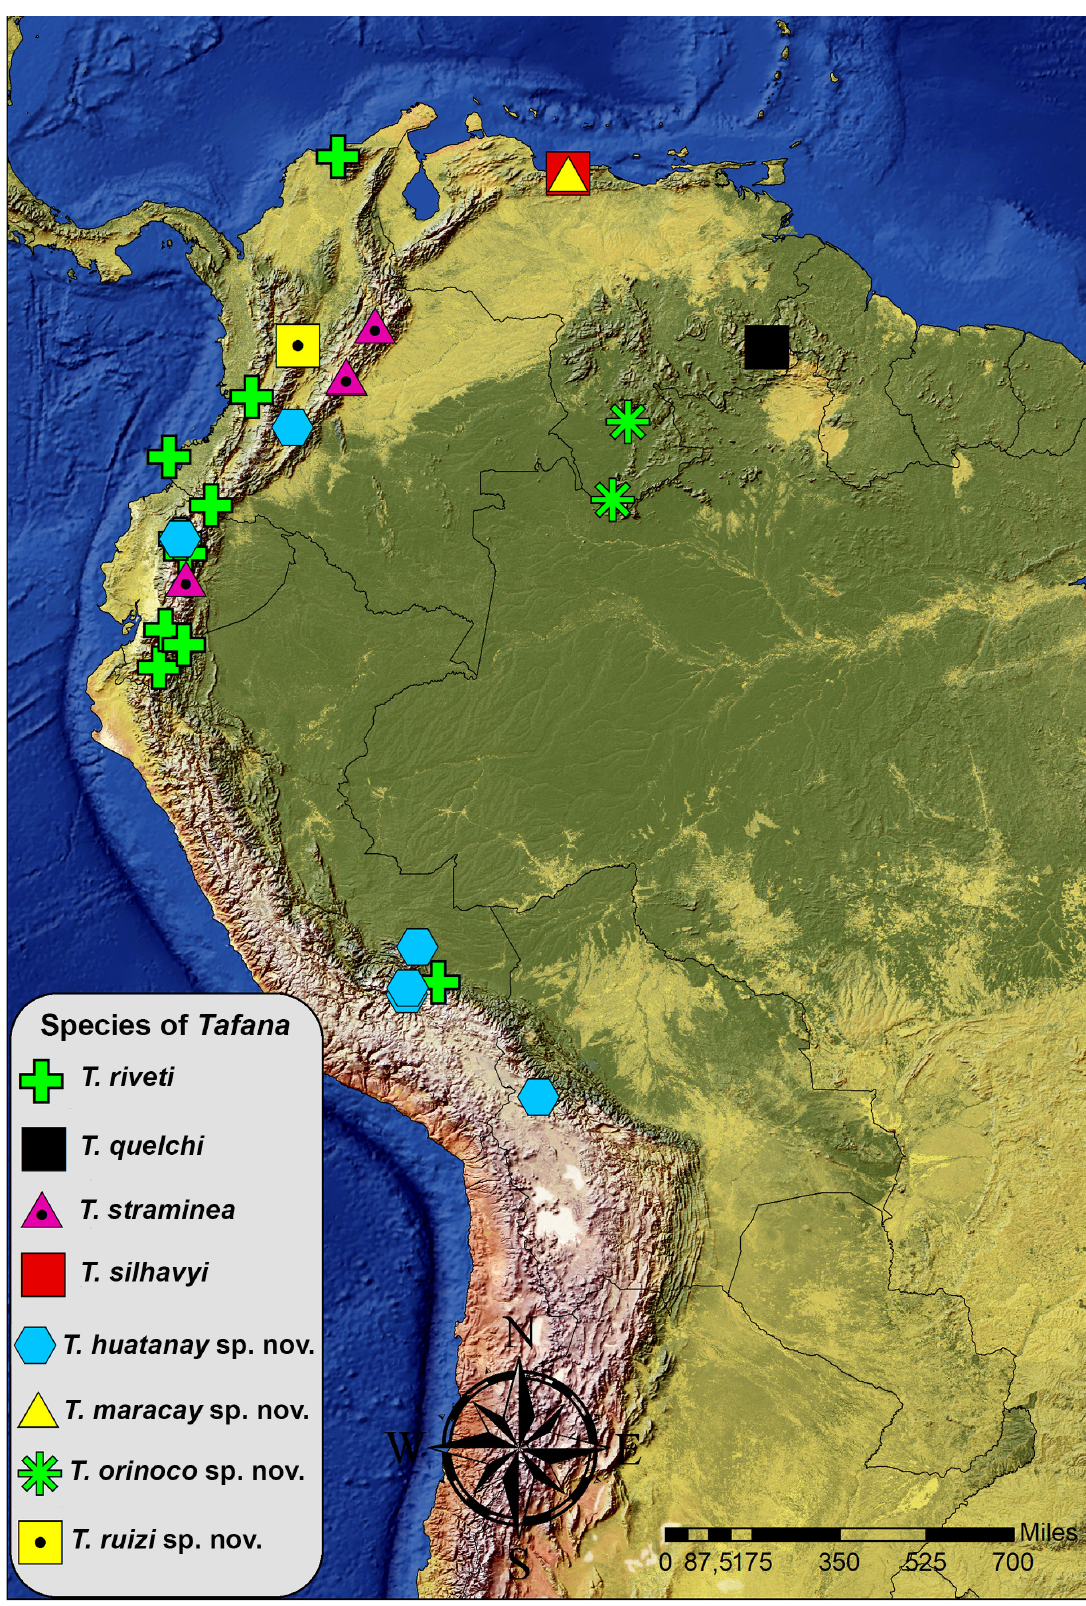
Fig. 34. Distribution map of species of Tafana